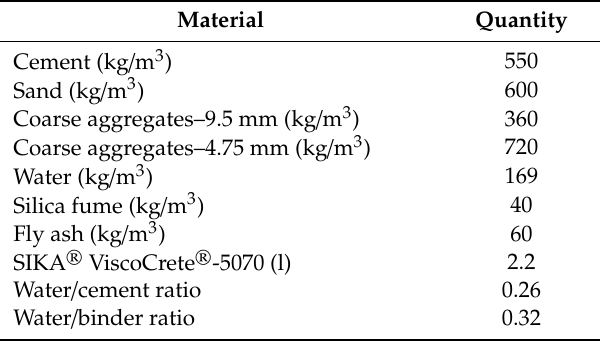
Table 3. Mix design proportions of benchmark SCC Mix.